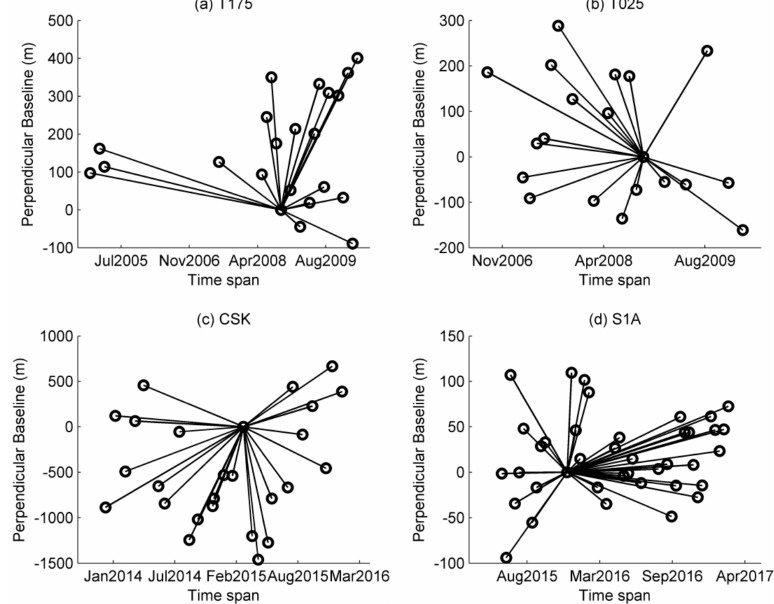
Figure 3. ( a ) ASAR T175, ( b ) ASAR T025, ( c ) CSK and ( d ) S1 archive with acquisition time and length of perpendicular baseline relative to the reference